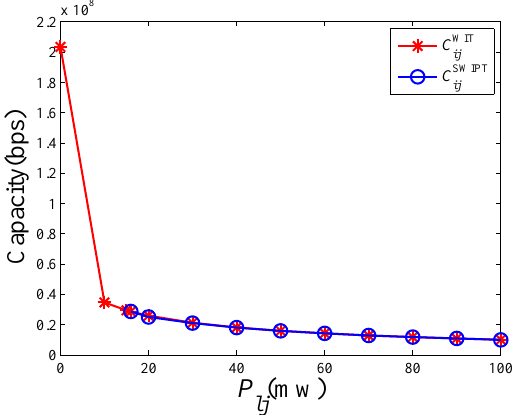
Figure 7. The capacity of WIT and SWIPT under different interference powers.